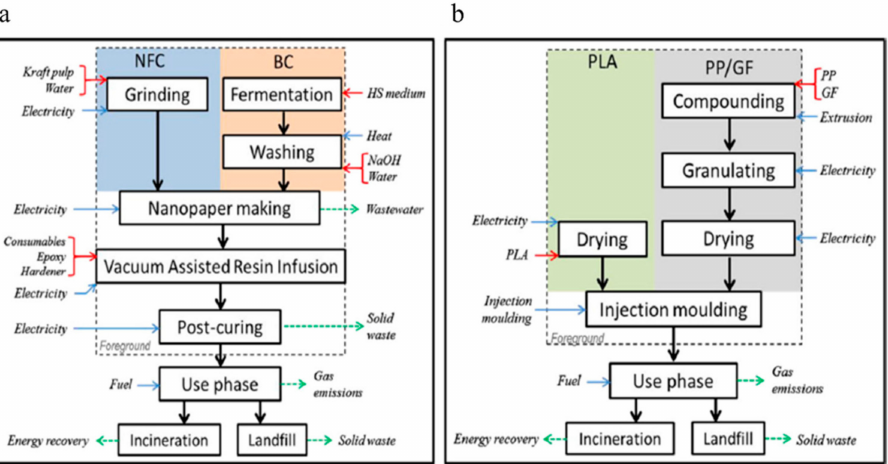
Figure 7. System boundaries for the life cycle of the ( a ) epoxy composites containing BC and CNF, ( b ) pure PLA and GF/PP composites. Red arrow: raw material required, blue: energy consumption, green arrow: material and energy wastes